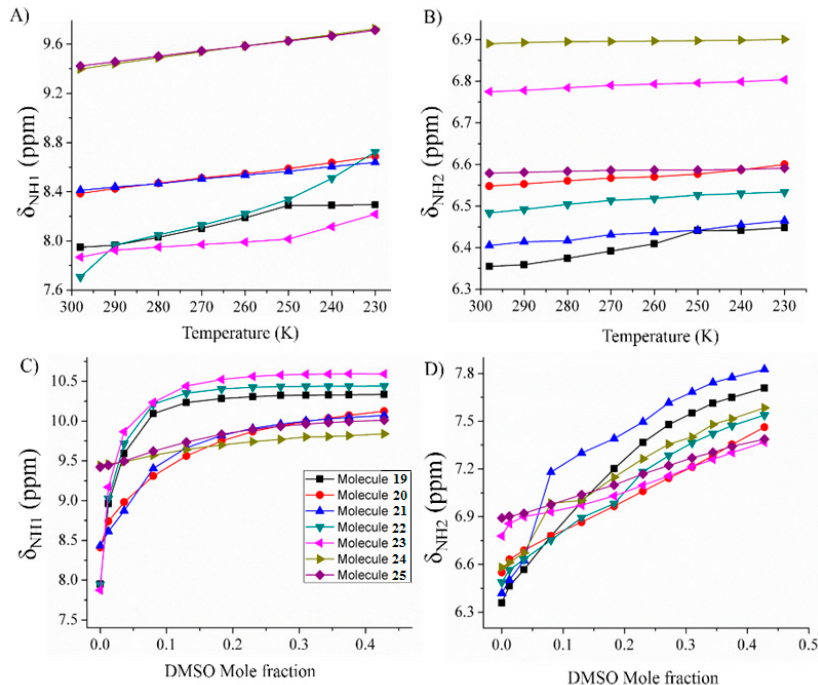
Figure 21. The variation of the chemical shift of; ( A ) NH (1) ; ( B ) NH (2) protons with temperature; ( C ) NH (1) and ( D ) NH (2) protons with the incremental addition of DMSO- d 6 for the molecules 19 – 25 in the solvent CDCl 3 at 298 K. The color code for the molecules are given as an inset in Figure 21C, and is same for Figure 21A–D.